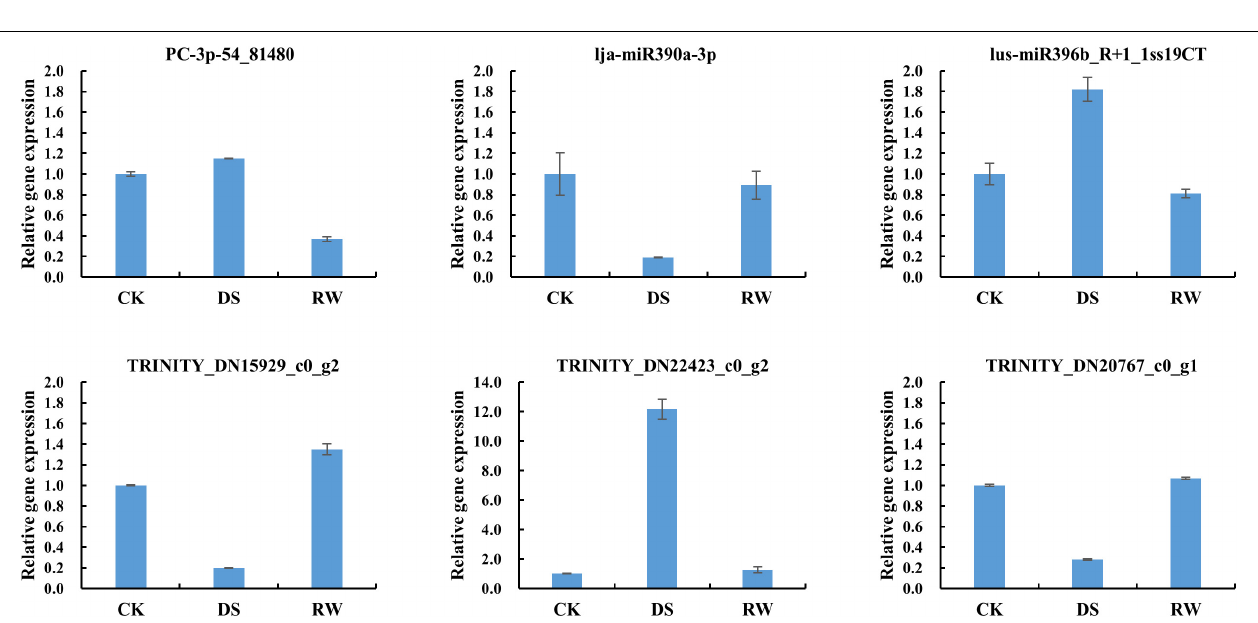
FIGURE 6 | The target plots (T-plots) for target genes of miRNAs by degradome sequencing. X -axis, the site position of target transcript. Y -axis, the normal abundance of raw tags. Red circle, the cleavage site.